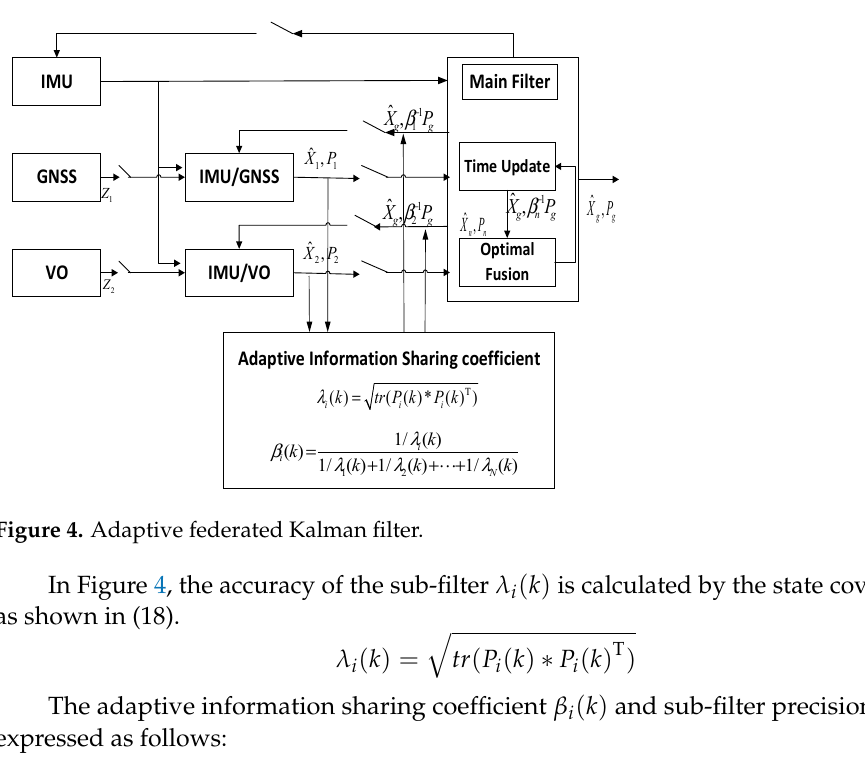
Figure 3. Federated Kalman filter.